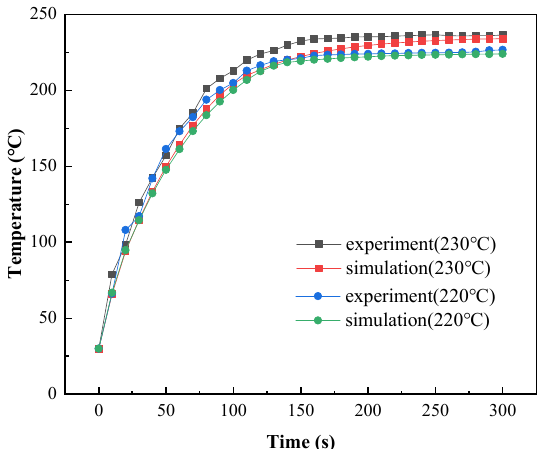
Figure 20. Comparison of experimental and simulated temperatures during the curing process.